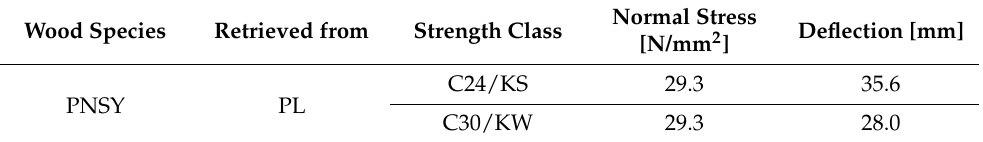
Table 13. Normal stresses and deflection (displacement) of C-version long frames made of glued material with a finger-jointed lamella length of 400 mm (pine, country of origin: Poland).